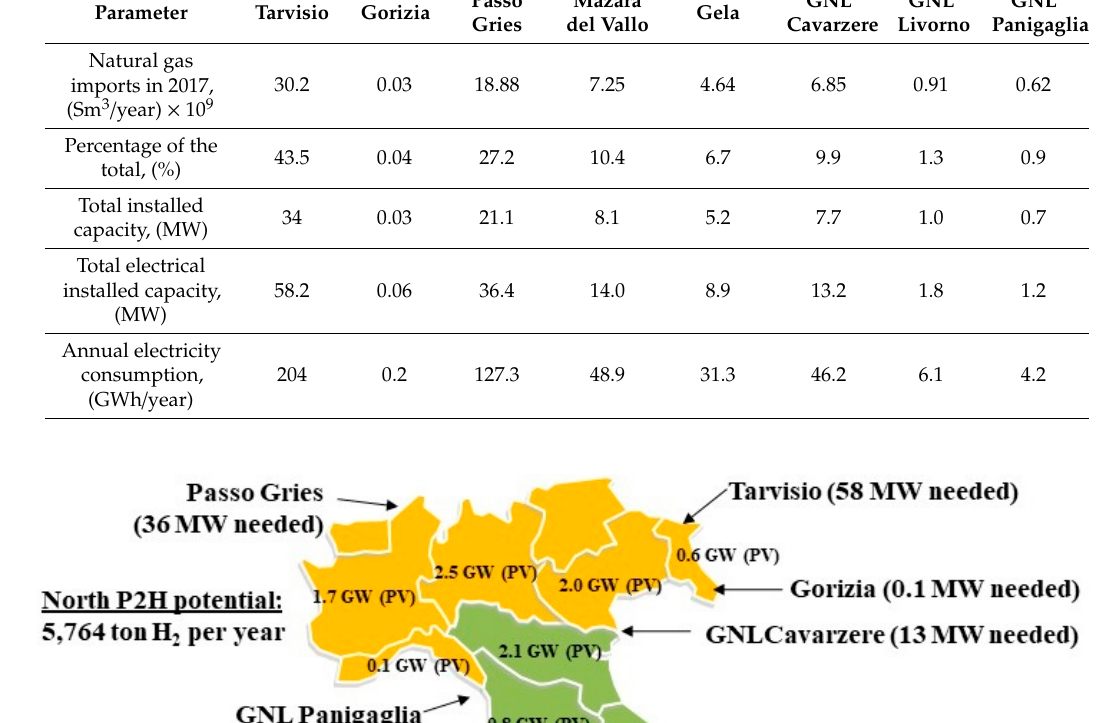
Table 10. Preliminary estimation of Italian P2H plants’ total size.